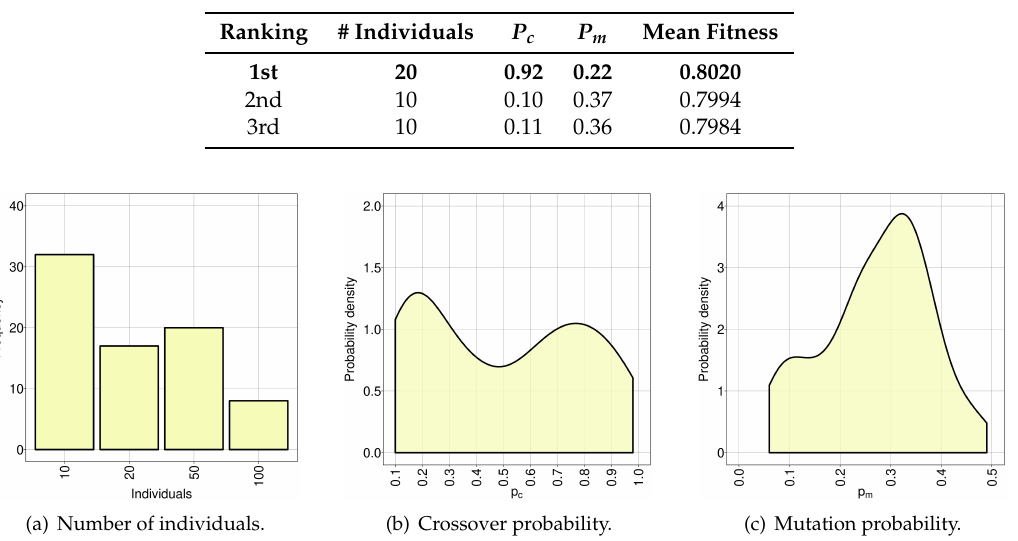
Table 4. The three best parameter configurations of EA. The configuration chosen is in bold.